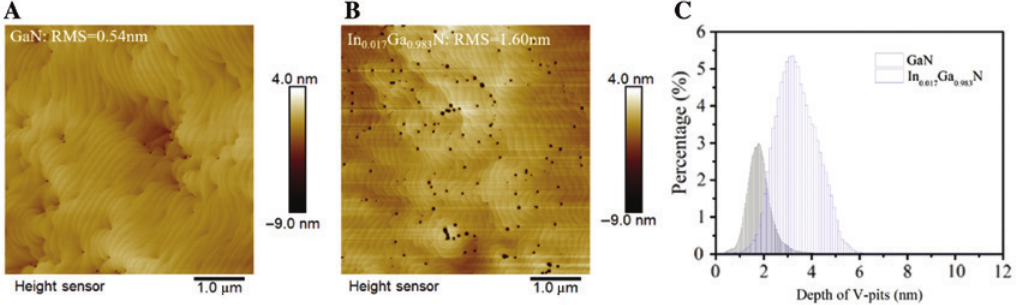
Ga N layer is 0.54 nm and 0.017 0.983 Ga N layer is clearly much bigger than those in u-GaN layer. In addition, 0.017 0.983 Ga N layer are much larger than that in the 93 nm-thick u-GaN layer. 0.017 0.983